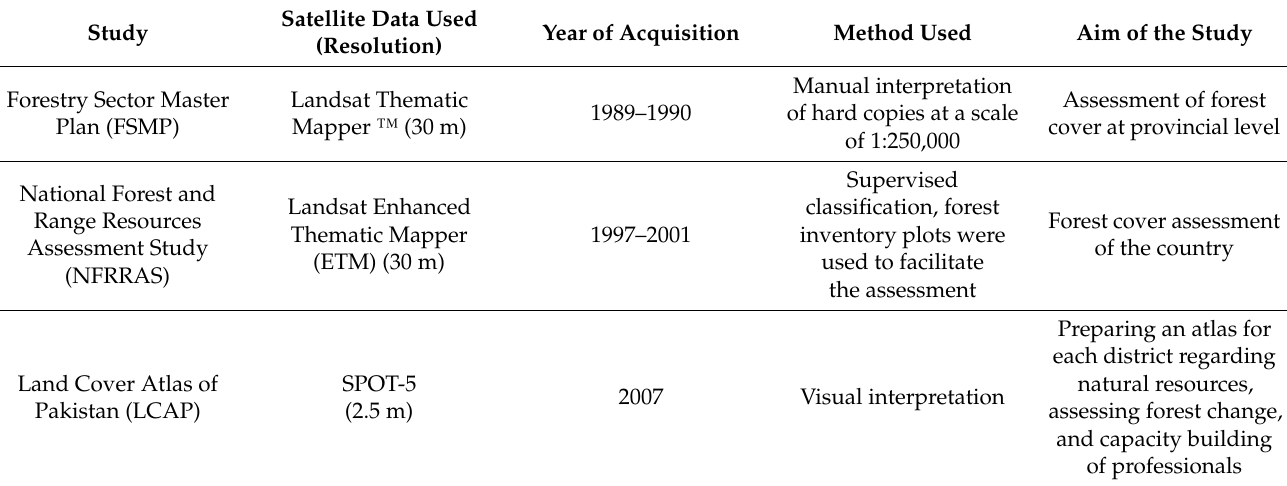
Table 1. Major national studies of forest cover in Pakistan.